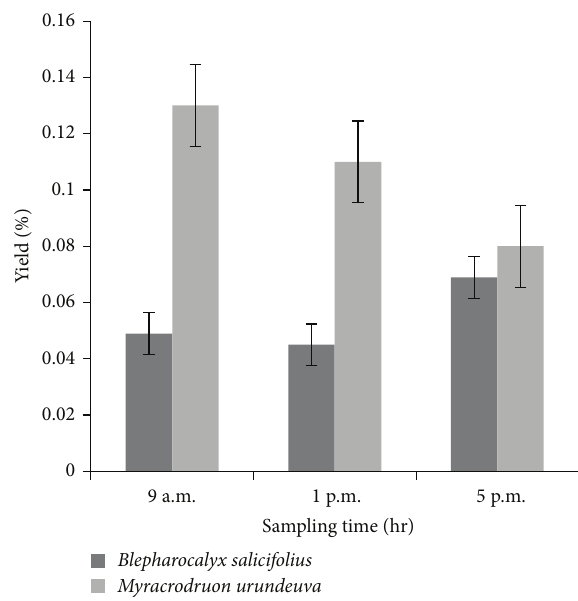
Figure 2: Blepharocalyx salicifolius and Myracrodruon urundeuva essential oils yields obtained from leaves harvested at day